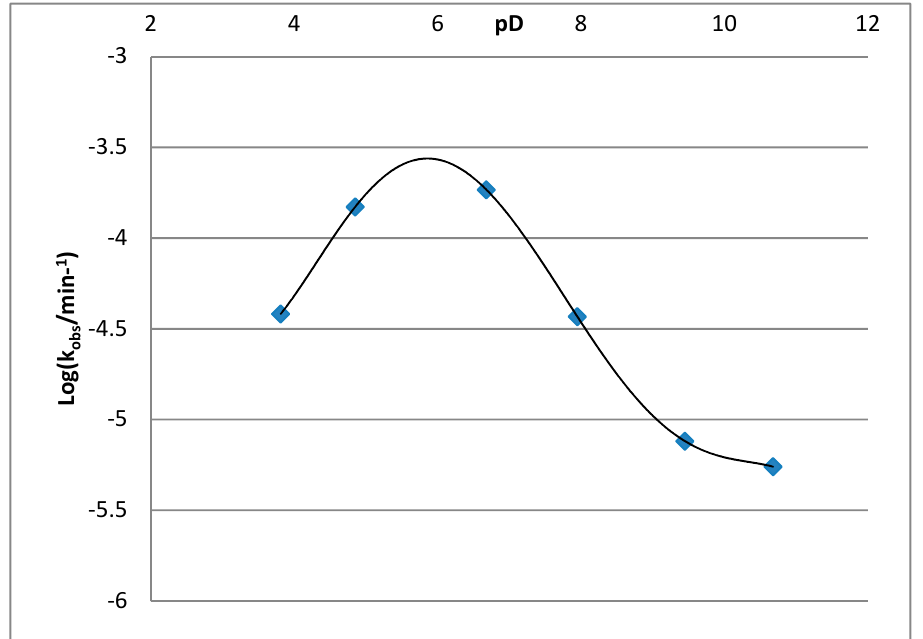
Figure 6. pD-rate profile for the hydrolysis of 2 . HCl.